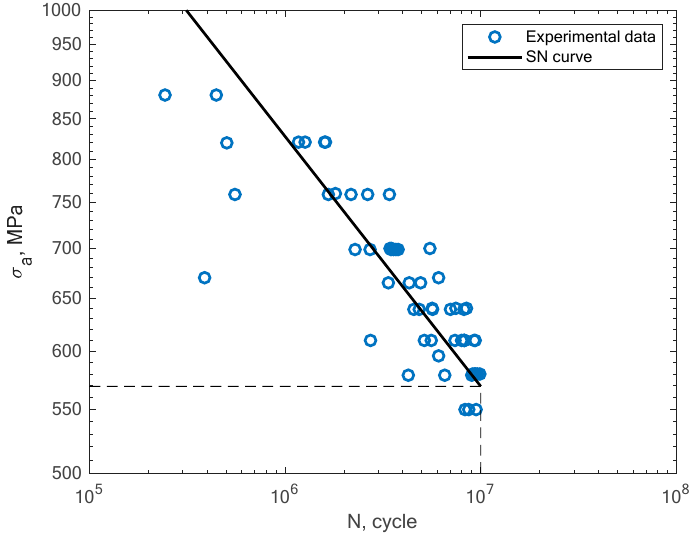
Figure 9. S–N curve for the experimental rotating bending fatigue test results reported by Croccolo et al. [16] .